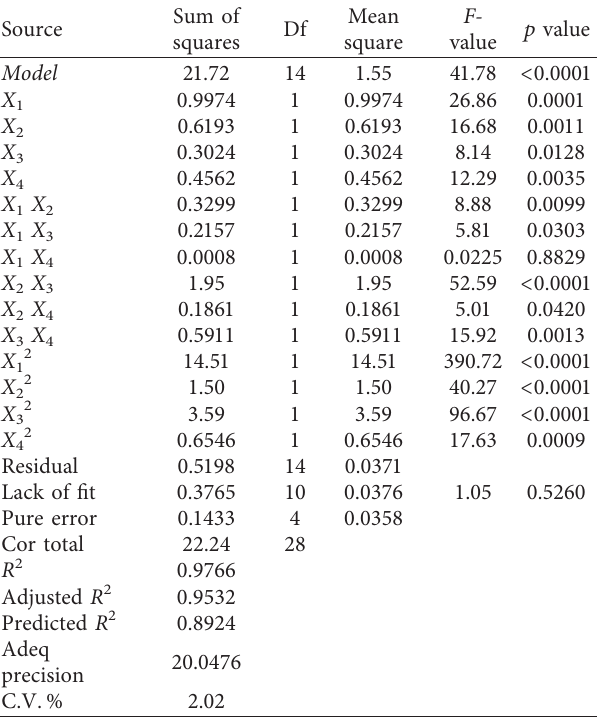
Table 4: ANOVA for response surface quadratic model analysis of the experimental results 1 .